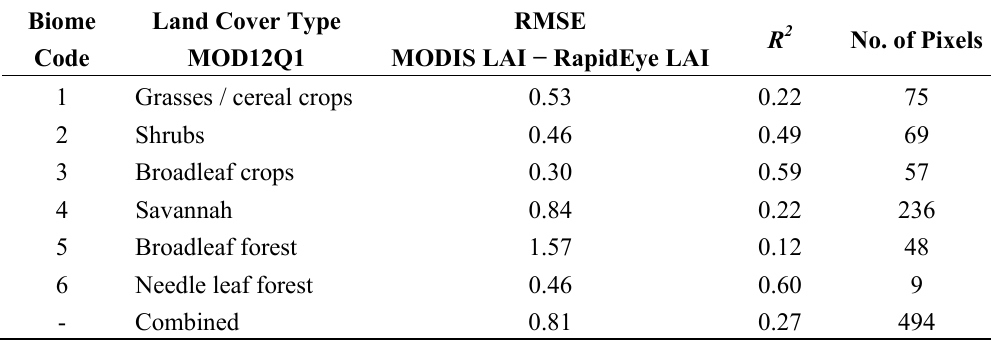
Table 4. RMSE and number of pixels for the relationships MODIS LAI vs. RapidEye LAI for the six biomes of the MODIS classification scheme. RapidEye LAI data were aggregated at 1 km based on the position of MODIS